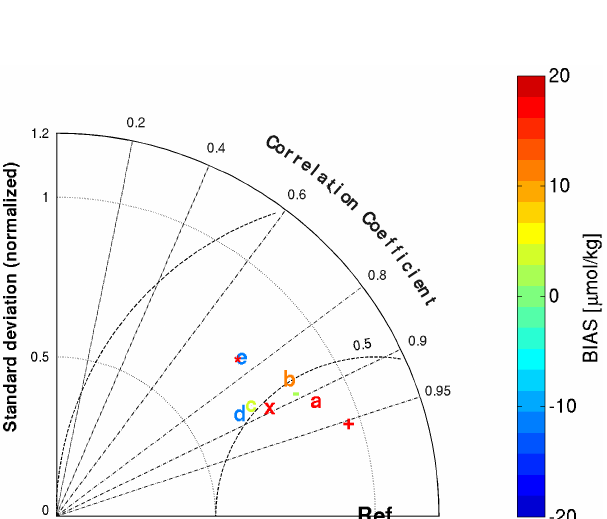
Figure 3. Taylor diagram of alkalinity of the mean annual model and observation fields for the following layers: surface (a) , 50– 100m (b) , 100–200m (c) , 200–1500m (d) and 1500–4000m (e) and for the following seasons at the surface layer: winter ( + ) , spring ( − ) summer (x) and autumn (*). The colour of the symbols and the bar report the bias (mean model–observation